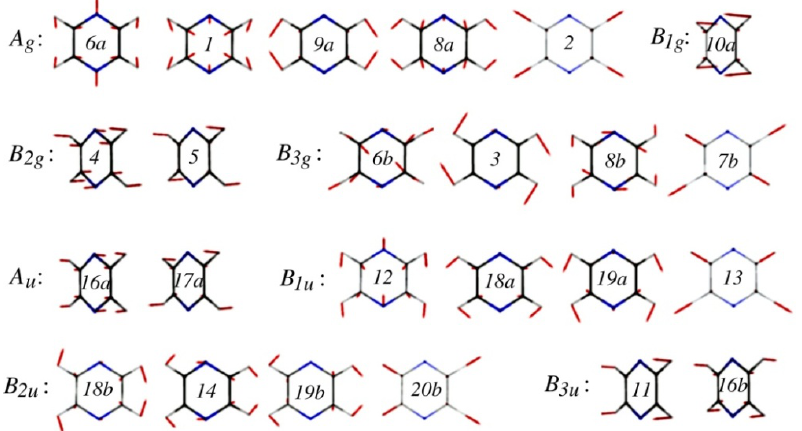
Figure 3. Normal modes of pyrazine calculated at the MP2/aug-cc-pVDZ level. They are labeled using Wilson’s numbering scheme for benzene.